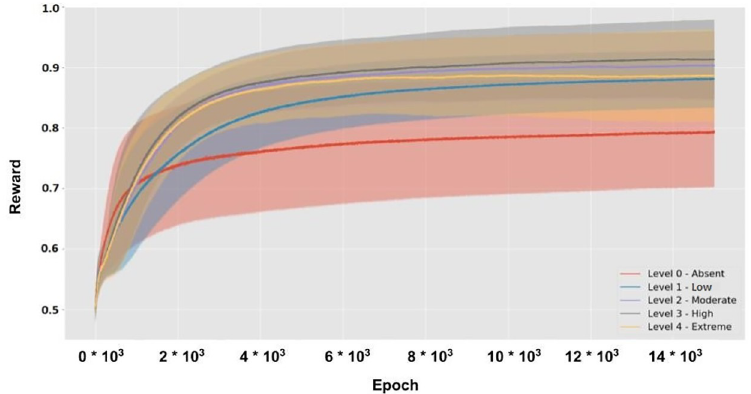
Fig 5. Reward per epoch of the five models involving different UL/RL levels, averaged over the models using a given level. Shaded areas represent the standard deviation.